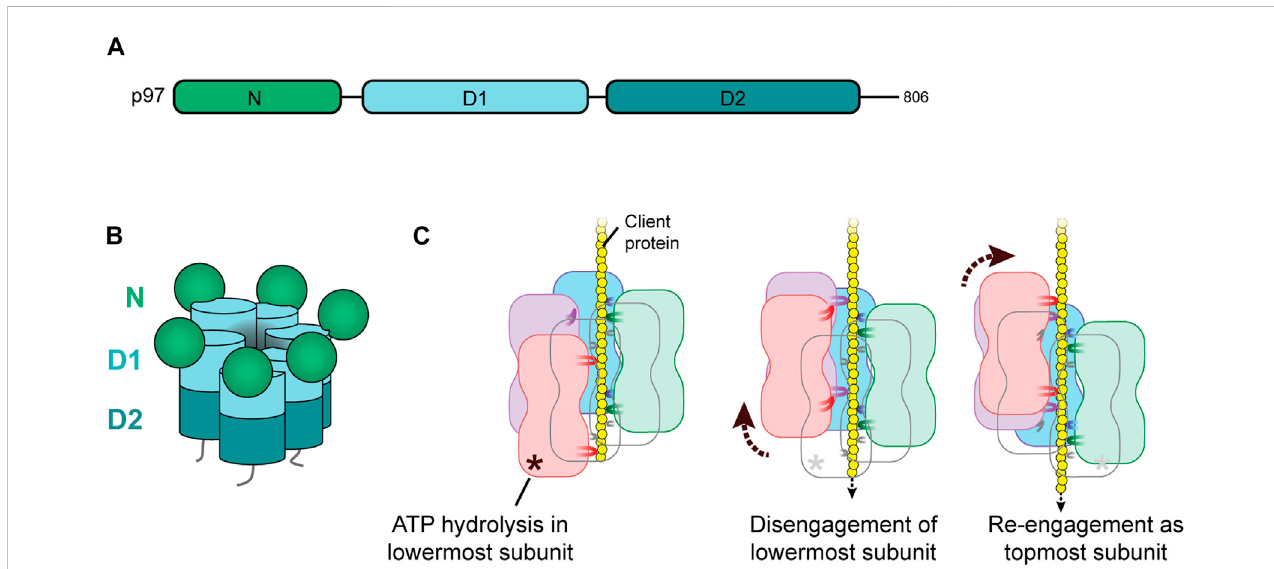
FIGURE 1 Structure and client threading mechanism of p97. (A) Domain structure of p97. Each p97 subunit comprises an N-terminal domain and two AAA ATPase domains, D1 and D2. (B) Cartoon representation of the p97 hexamer in staircase con fi guration around the central channel. (C) Hand-over-hand mechanism for client threading by p97. When the client protein (yellow) is inserted into the central channel of p97, hydrophobicporeloops of D1 and D2 interact with the client backbone. Each subunit binds two residues below the previous subunit (in clockwise direction) which sets the p97 hexamer in the right-handed staircase con fi guration. ATP hydrolysis in the lowermost subunit (orange) triggers the retraction of its pore loops and disengagement of the subunit (middle panel) creating a seam in the hexamer. Subsequent ADP release and re-binding of ATP induces re-engagement of this subunit as the topmost subunit (right panel). Propagation of ATP hydrolysis and up-movement of subunits around the hexamer in counterclockwise direction threads the client through the